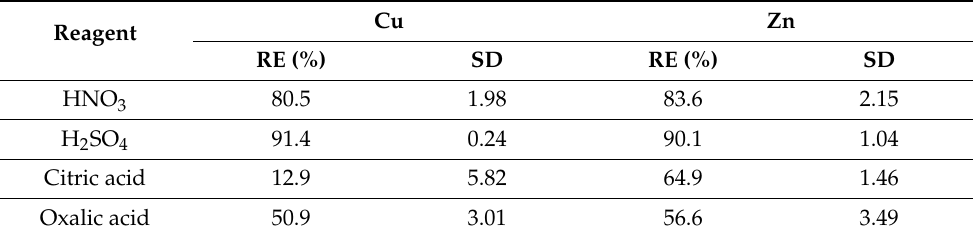
Table 2. Removal efficiency with chemical reagents (n =